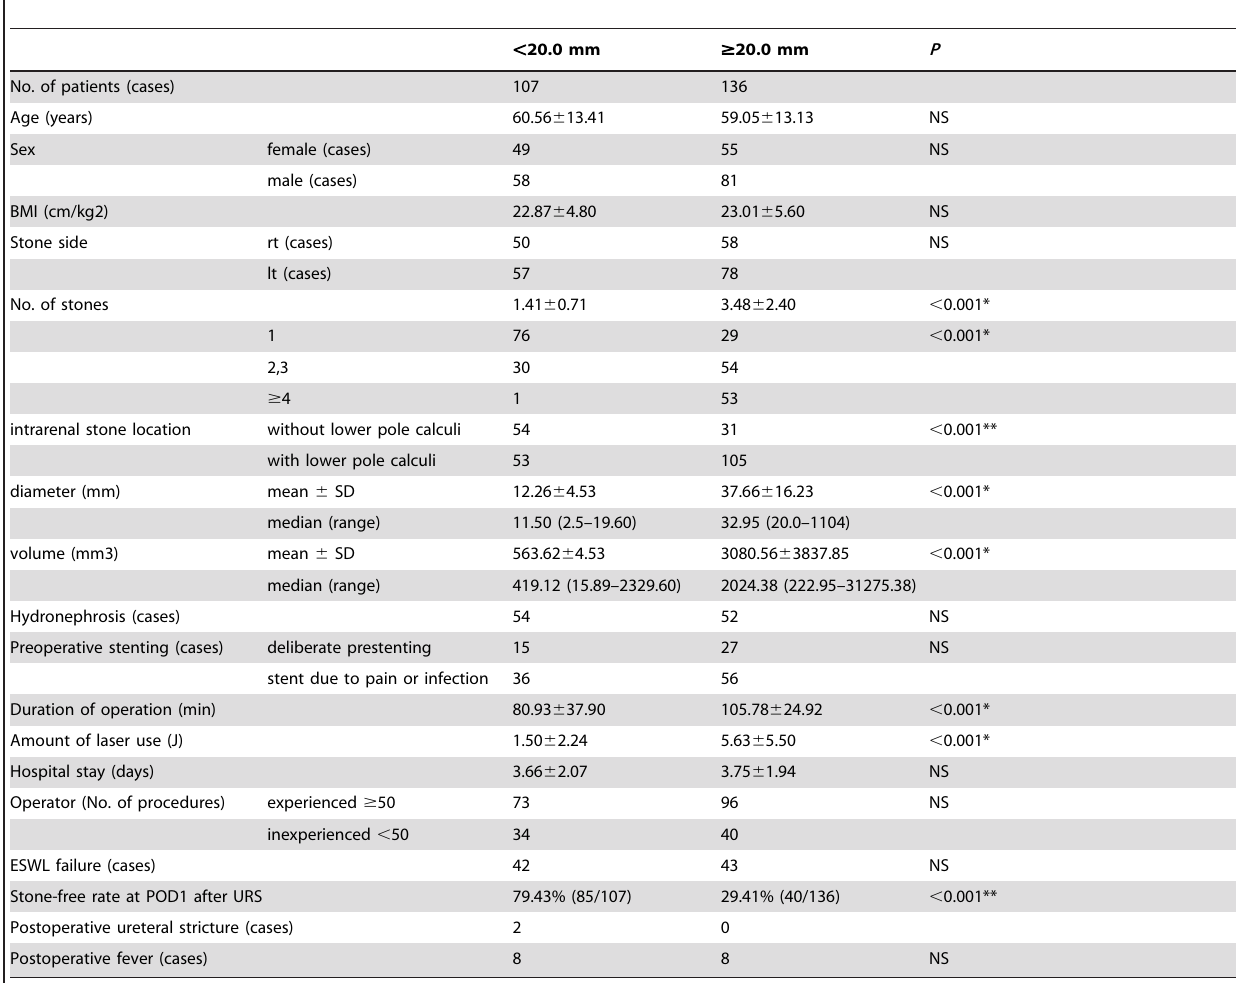
Table 1. Comparison of patient and stone data between cases with less than 20.0 mm stone diameter and more than 20.0 mm stone diameter.